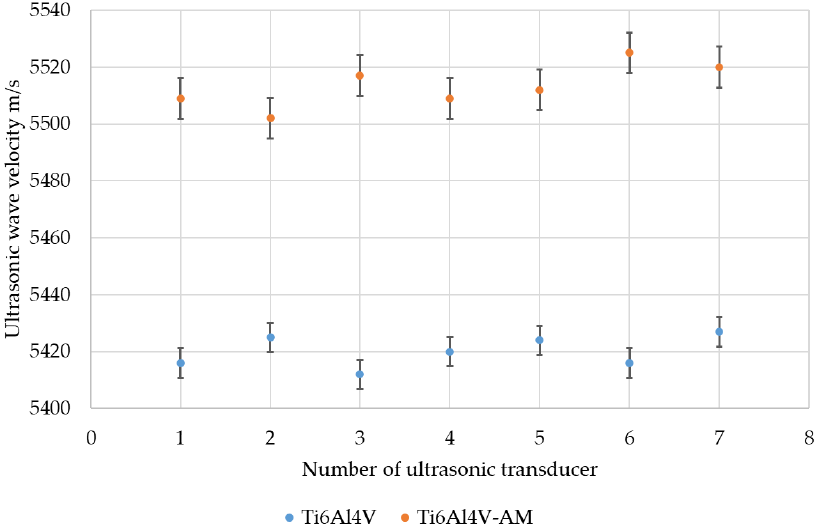
Figure 2. Average ultrasonic wave velocity values for the material Ti6Al4V and Ti6Al4V-AM.